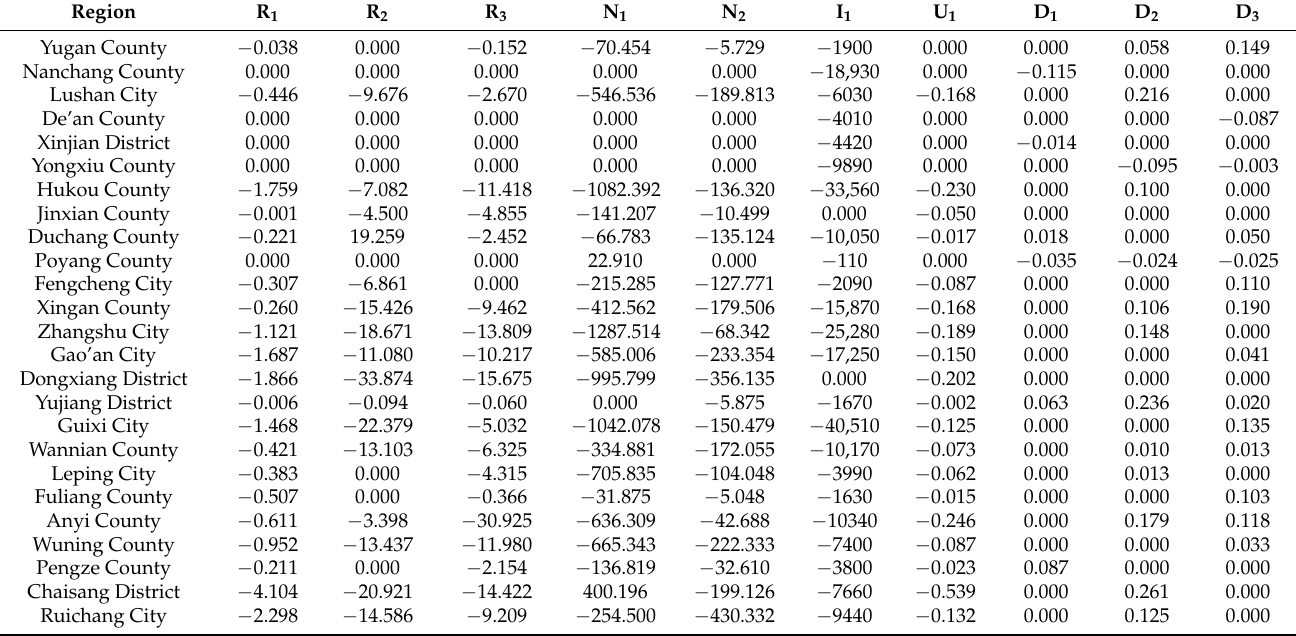
Table 4. Redundancy of input-output indicators of each county (district or city) in the Poyang Lake area in